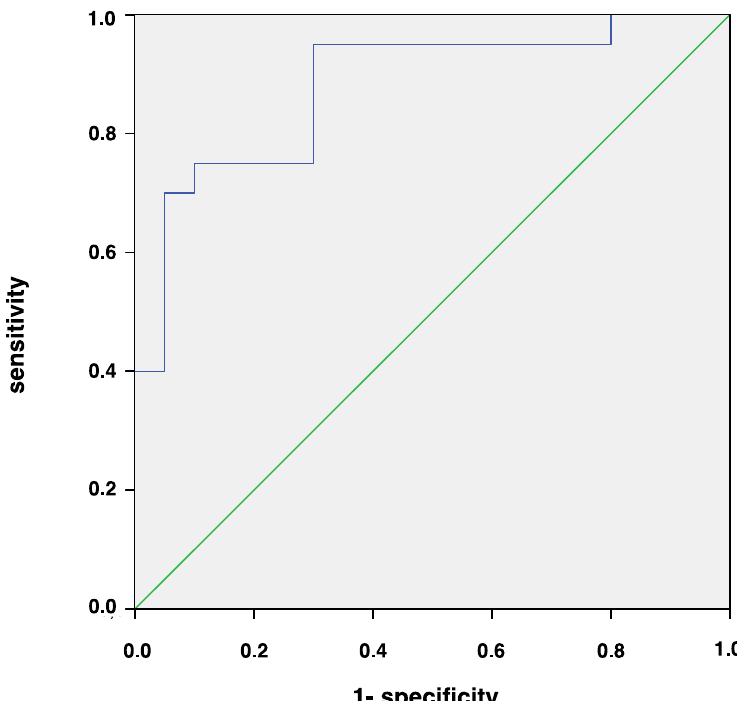
Figure 5. Receiver operating characteristic (ROC) curve for IL-1 β amount in moderate pocket sites comparing stage III periodontitis patients with rapid (Grade C) versus moderate (Grade B) rates of progression.